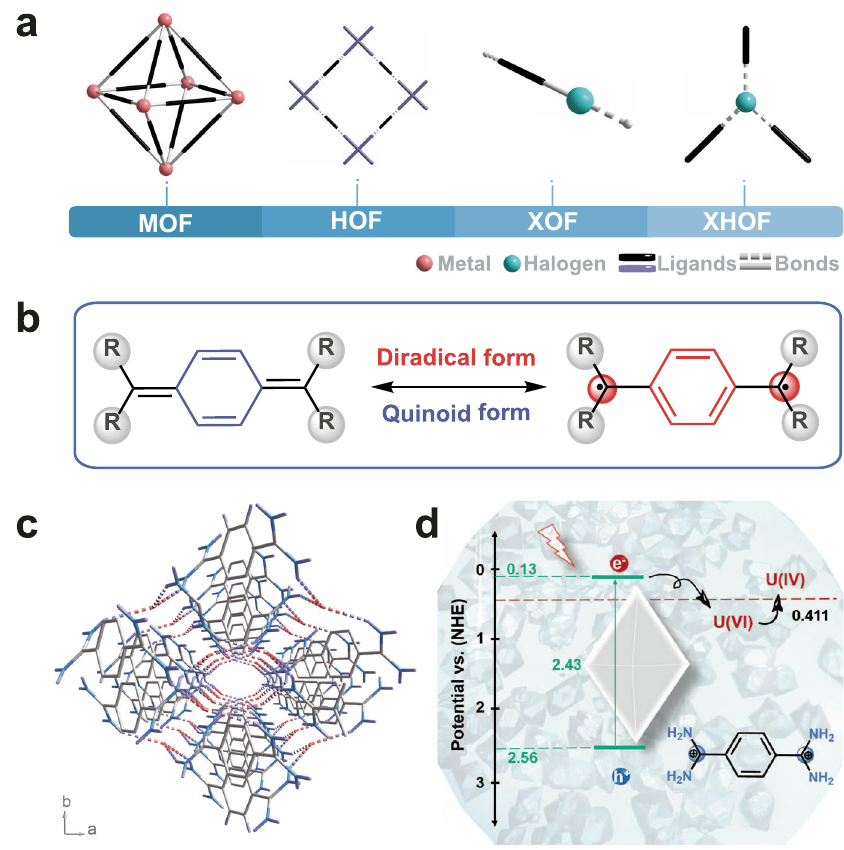
Fig. 1 Schematic diagram of the mechanism for U(VI) immobilization by XHOF-TAQ. a Different connection models of the organic framework materials. b Resonance structures of the quinoid and diradical forms. c Illustration of the 3D structure of XHOF-TAQ. d Mechanism for electron and hole transfer during the photoreduction of